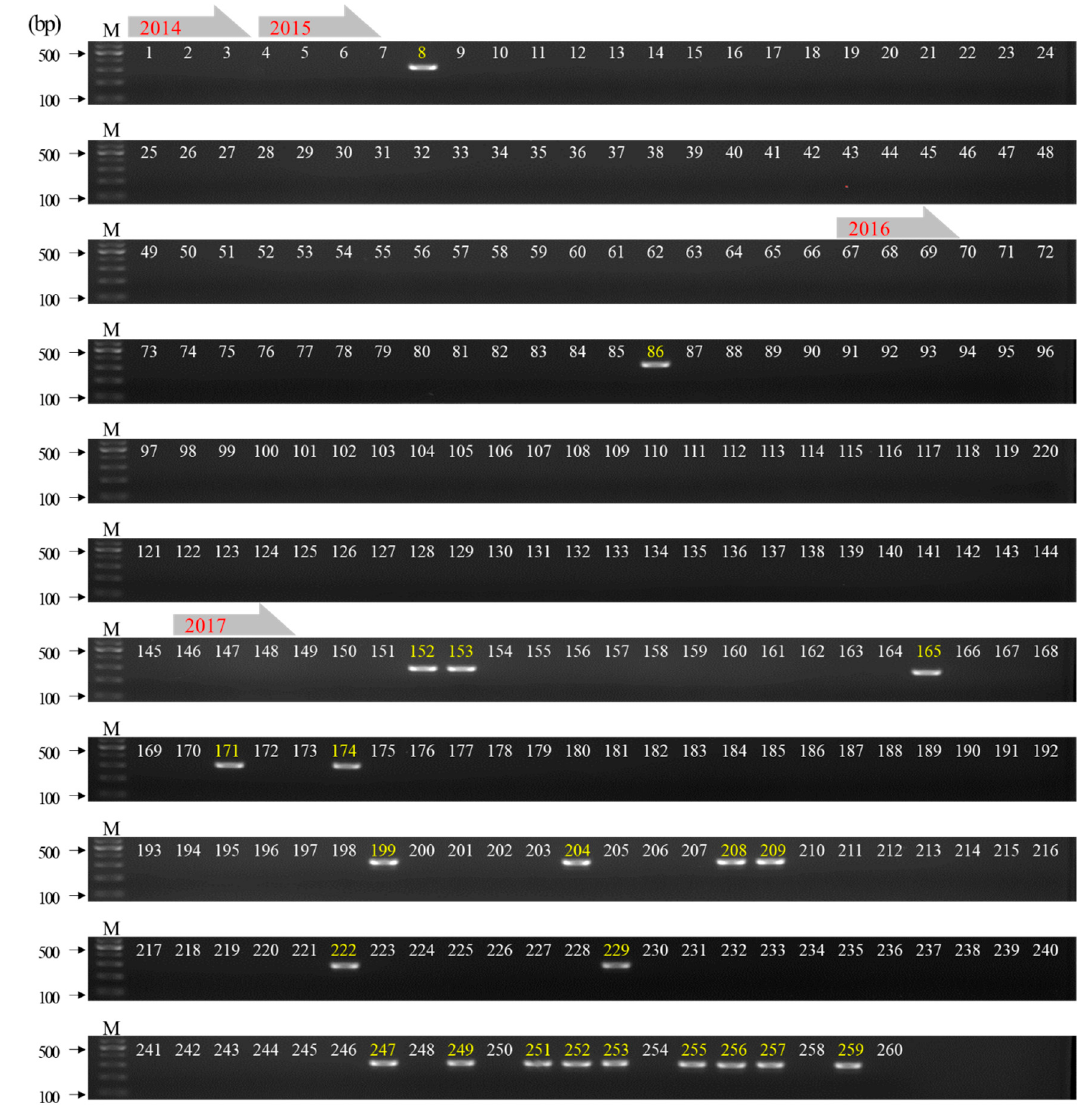
Figure 4. Application of the multiplex PCR method for living modified organism (LMO) identification with the collected suspicious canola samples. The numbers indicate the collection year of the suspicious canola samples (red) and are identified as LM canola (yellow).